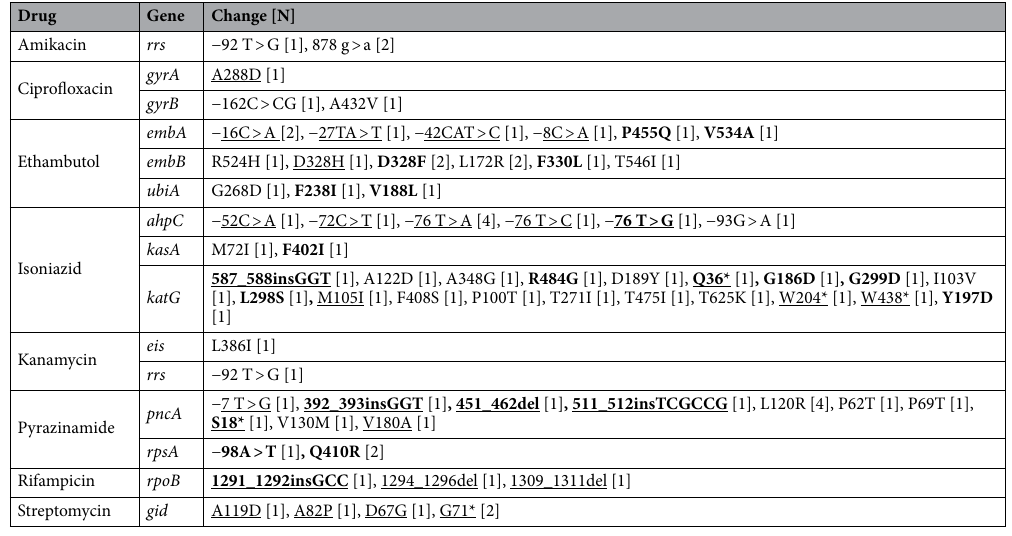
Table 3. Putative novel drug resistant mutations. *Based on absence in the curated TB-Profiler mutation list; bolded, if not observed in a large TB Global dataset (34 k 7 ); underlined, if with multiple levels of evidence for drug resistance (see S8